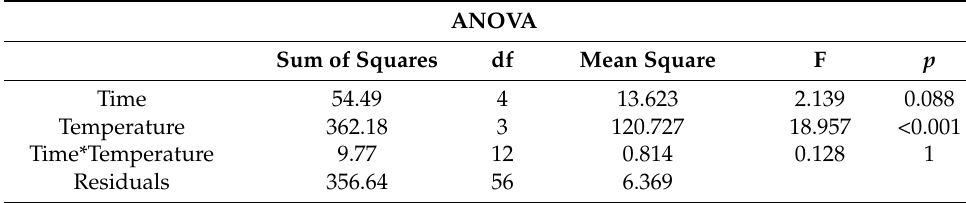
Table A1. ANOVA for pectin yield extraction.